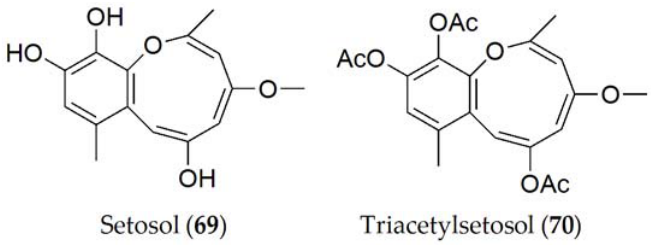
Figure 13. Phytotoxins isolated from Pleiochaeta setosa .